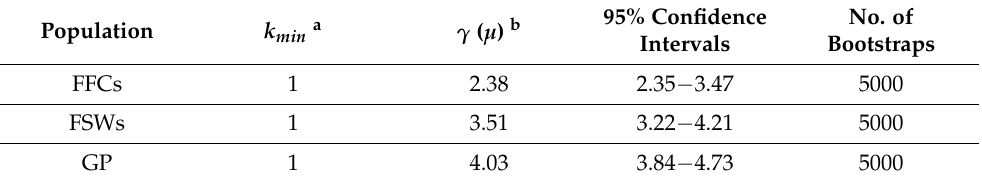
Table 3. Transmission network parameter values estimated per population.